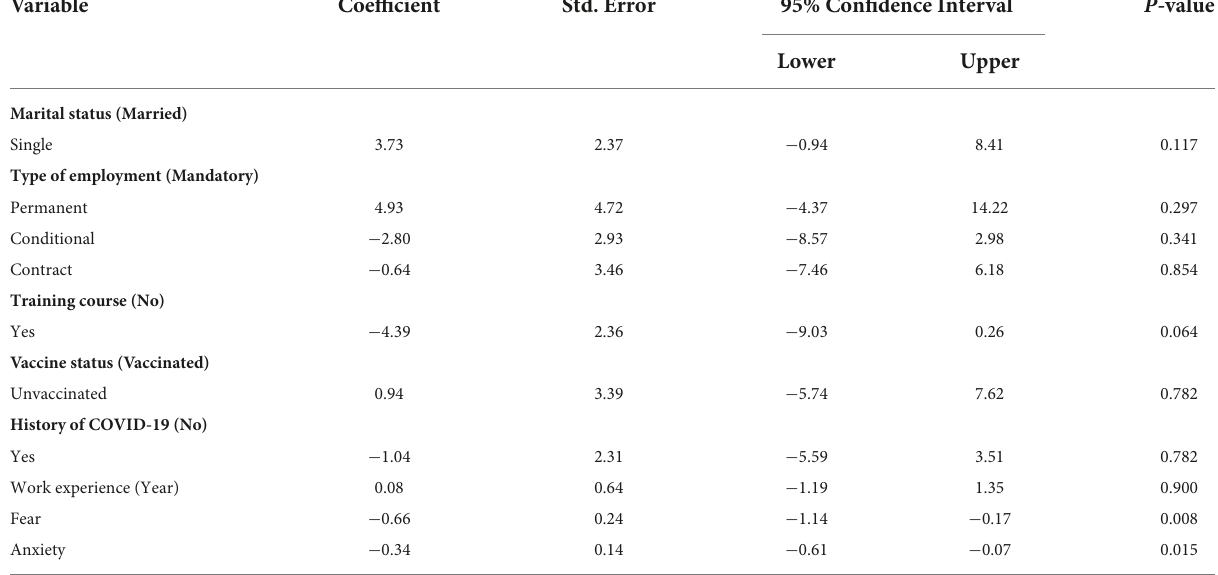
TABLE 2 Age and sex adjusted multiple linear regression model. Variable Coefficient Std. Error 95% Confidence Interval